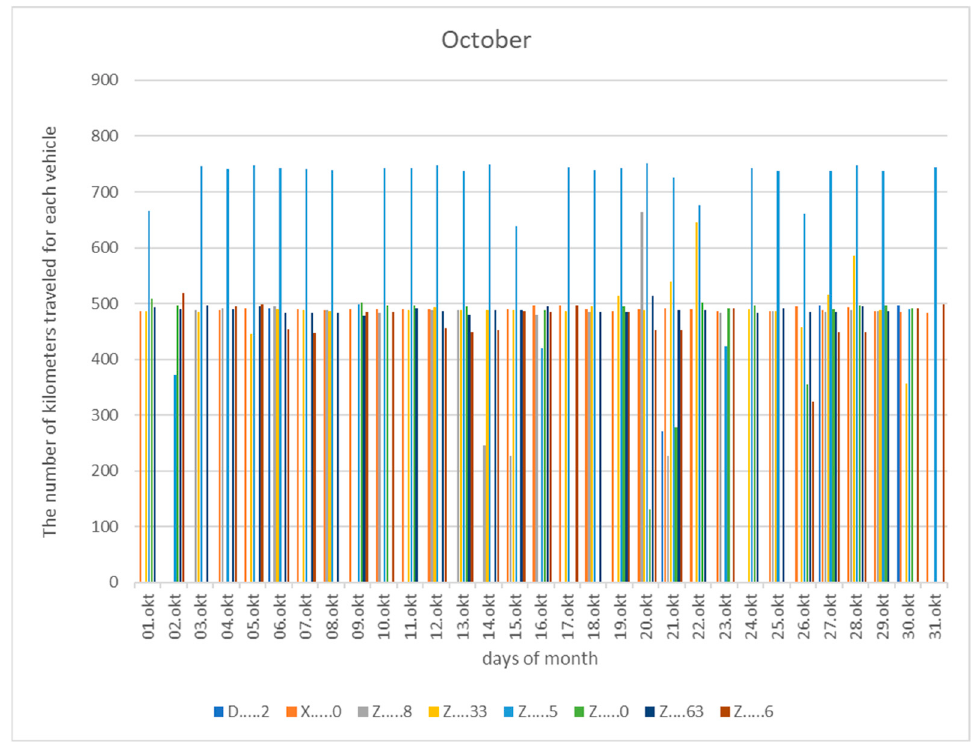
Figure 6. The number of kilometres travelled for each vehicle in October.